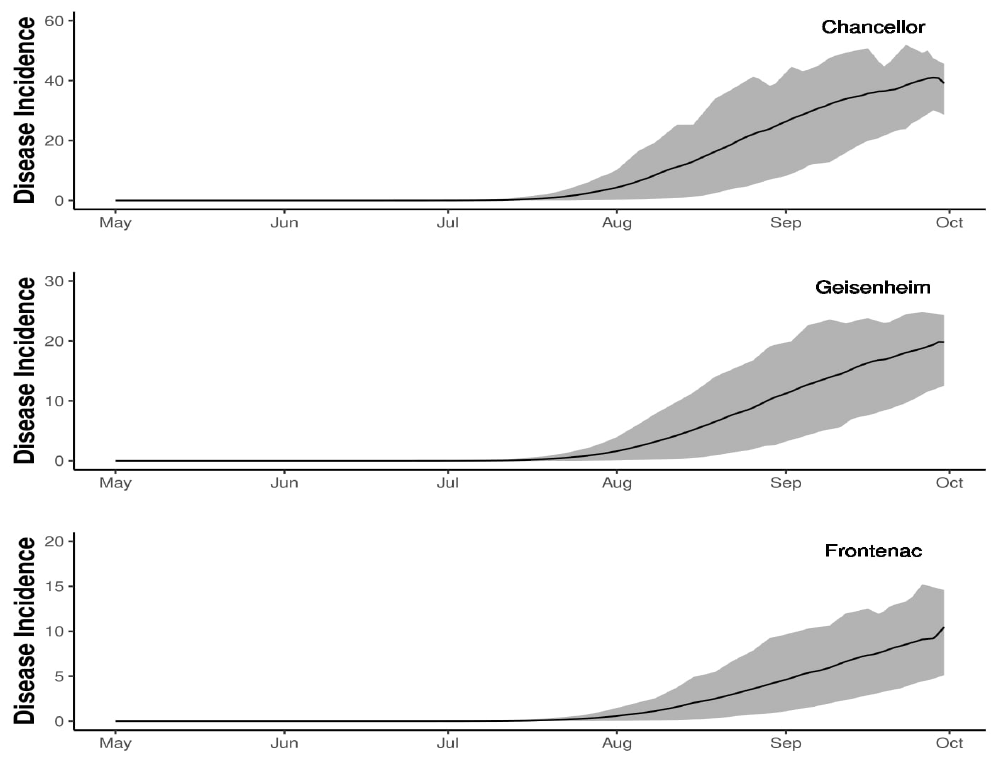
Figure 2. Seasonal climate variability and disease incidence (DI) (% infected/non-infected leaves) of grape powdery mildew (PM) through the growing season for northern hybrid grape cultivars with differing susceptibility (Chancellor, Geisenheim-318, Frontenac). The mean (solid line) is shown varying between minimum (lower bound) and maximum (upper bound) observed values